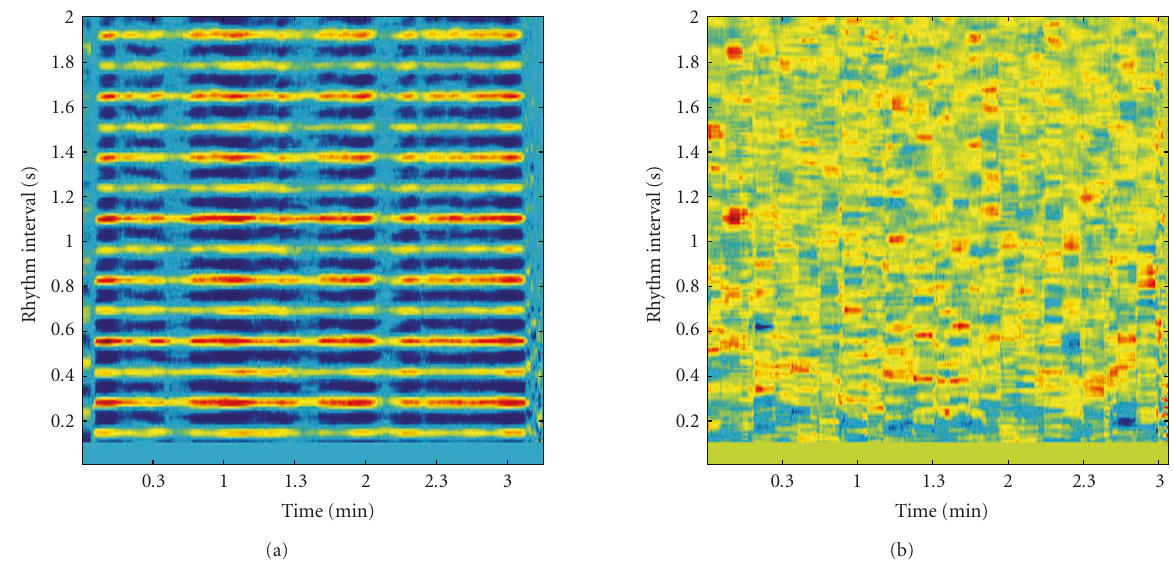
Figure 1: Rhythmogram of (a) Whenever, Wherever and (b) All of Me